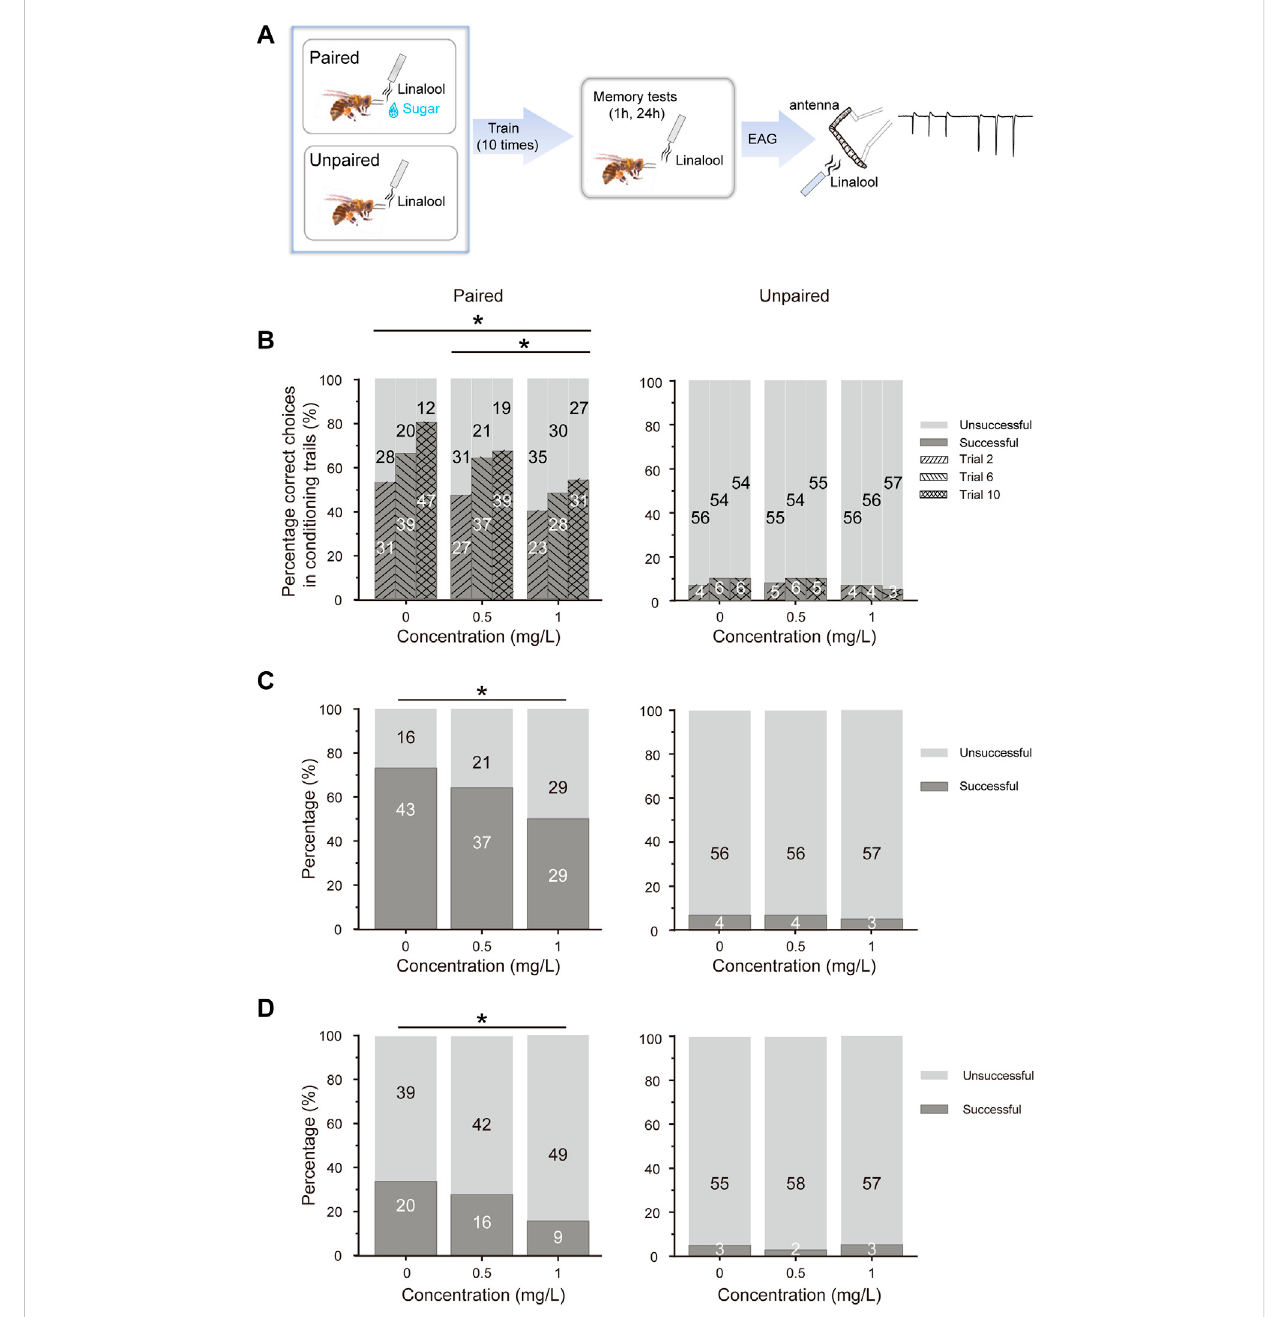
FIGURE 3 Thiaclopridexposurenegativelyimpactslearningacquisitionandmemoryretention. (A) Schematicrepresentationofolfactorylearningandmemory behaviors, as well as electroantennography (EAG) recordings, following training. The paired group received R-linalool as a conditioned stimulus in conjunction with a sucrose reward, whereas the unpaired group also received R-linalool, but without the sugar reward. The learning acquisition was repeated 10 times, and the memory recall was tested for 1 h (medium-term memory) and 24 h (long-term memory) after learning acquisition. After the memory retention testing sessions, EAG recordings were made from the trained honeybee antenna. (B) Honeybee learning acquisition was in fl uenced by three thiacloprid concentrations. The percentages of correct choices for the paired (left panel) and unpaired (right panel) groups were plottedastrainingsessions2,6,and10fromeachgroup. N =58beesinthepairedgroup,and N= 60beesintheunpairedgroup. (C,D) Memoryretention performance represented by recall success for the paired (left panel) and unpaired (right panel) groups in 1 h (medium-term) and 24 h (long-term) memoryatthreetreatmentconcentrations(0 mg/L,0.5 mg/L,and1 mg/L).Chi-squaredtest,withstarsindicatingstatistical differencesbetweengroups. * p < 0.05, ** p <